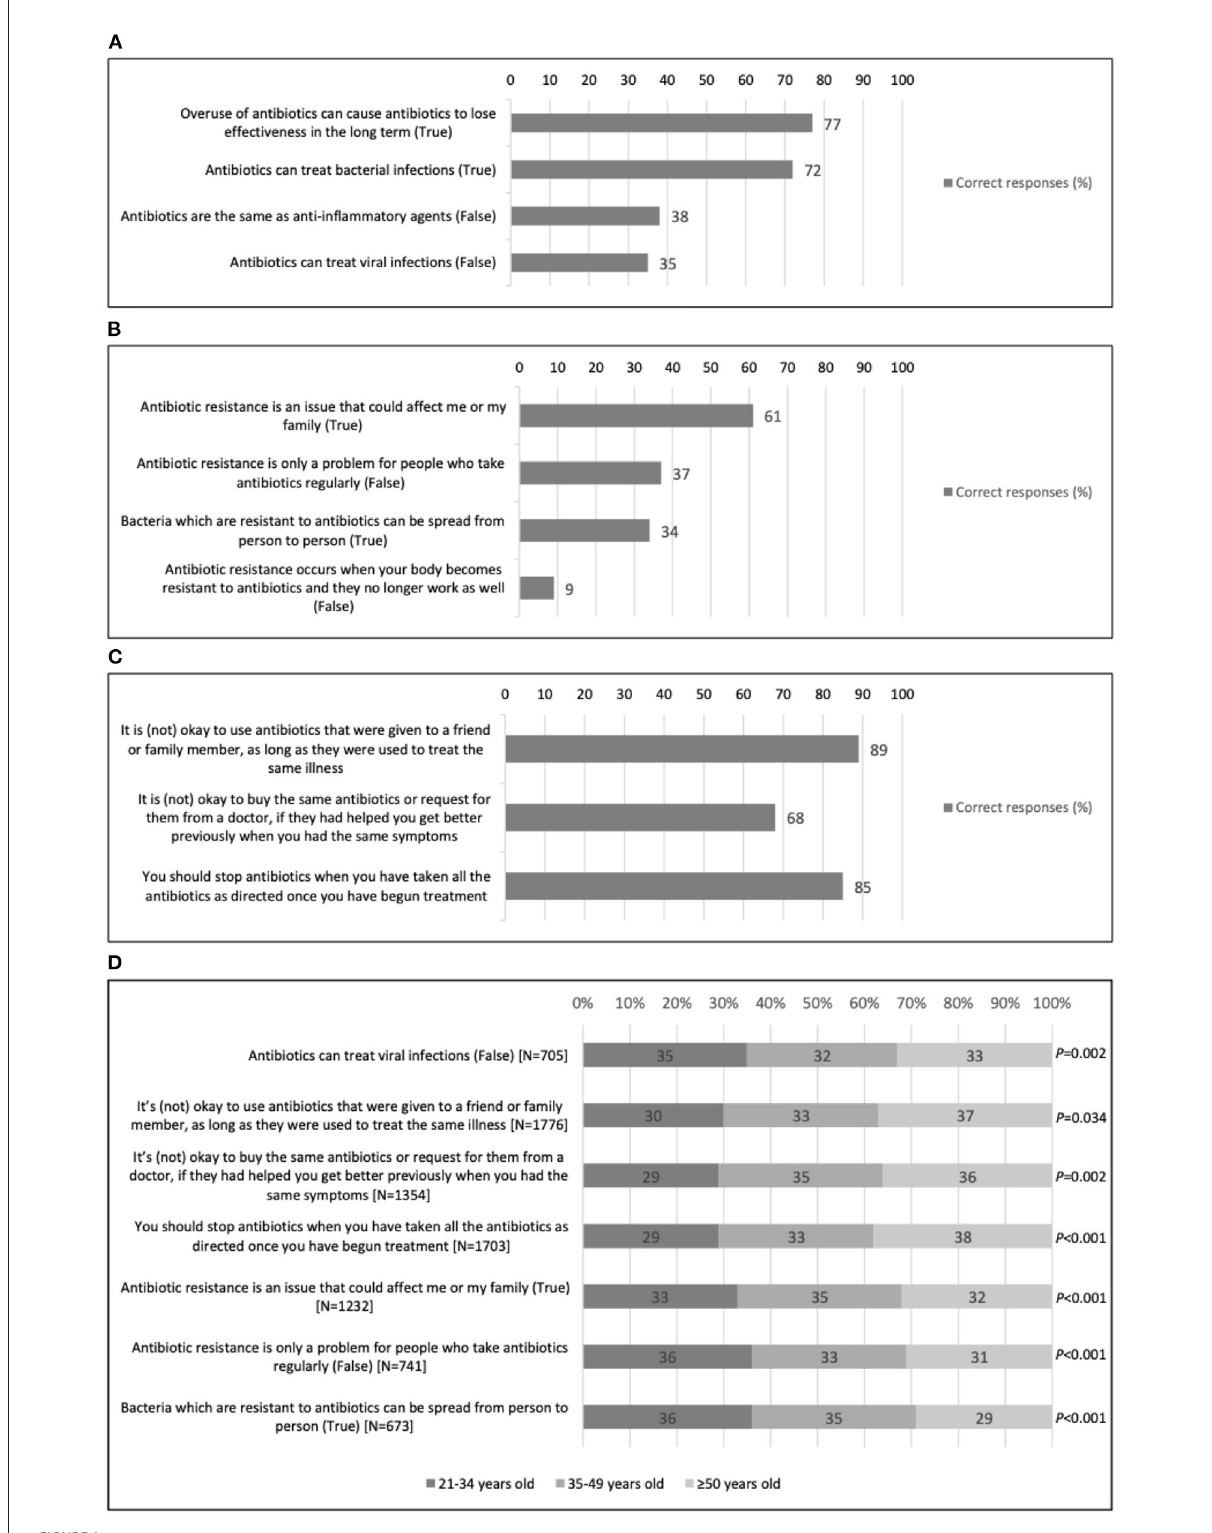
FIGURE1 Proportion of correct responses from 2004 Singapore residents on statements pertaining to antibiotic use and antimicrobial resistance (AMR), surveyed between November 2020 and January 2021. (A) Knowledge of statements related to understanding how antibiotics work. (B) Knowledge of statements related to antimicrobial resistance (AMR). (C) Knowledge related to appropriate ways of obtaining and taking antibiotics. (D) Understanding differences in correct response in (A–C) , stratified by age (only significant trends